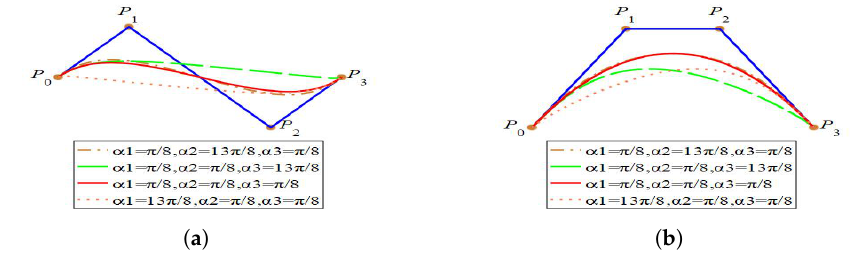
Figure 3. Cubic C-Bézier curves with different parameters. ( a ) α 1 = [ π